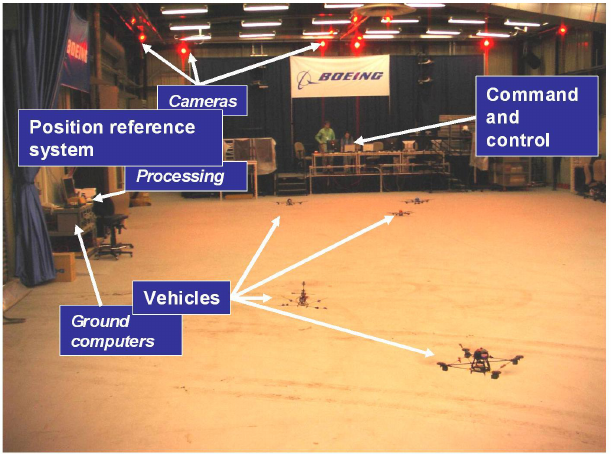
Figure 25. Pictorial view of Boeing’s Vehicle Swarm Technology Laboratory.